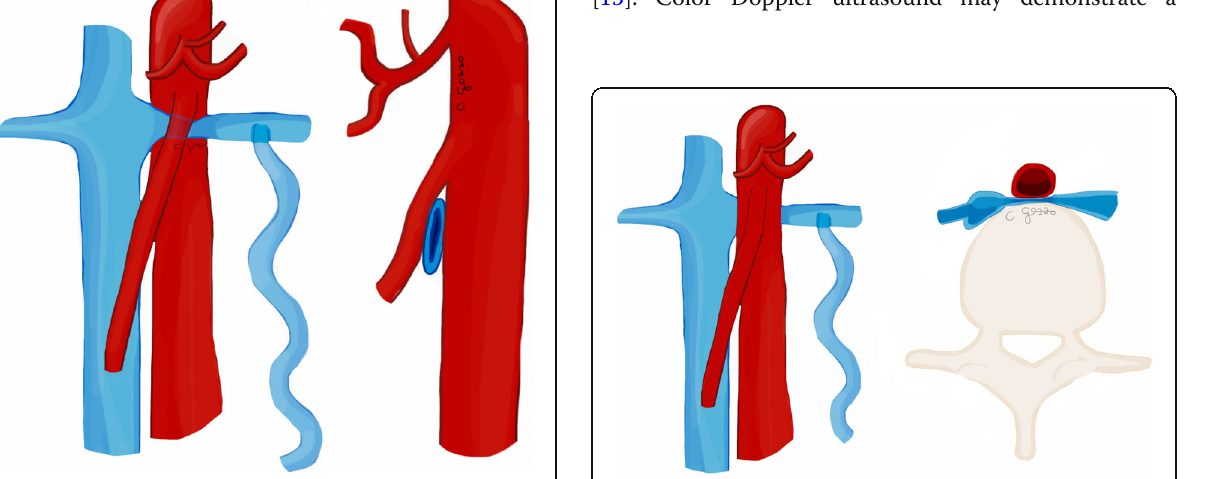
Fig. 4 Drawing illustrating the coronal and sagittal views of anterior Fig. 5 Drawing illustrating the coronal and axial views of posterior nutcracker